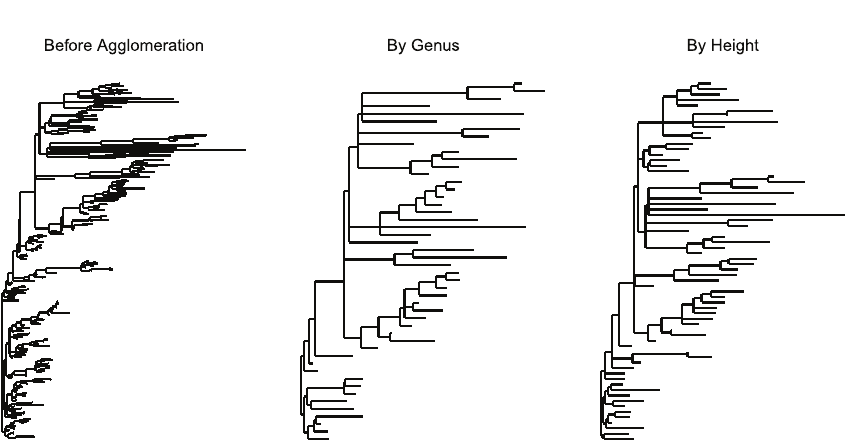
Figure 4. The original tree (left), taxonomic agglomeration at Genus rank (middle), phylogenetic agglomeration at a fixed distance of 0.4